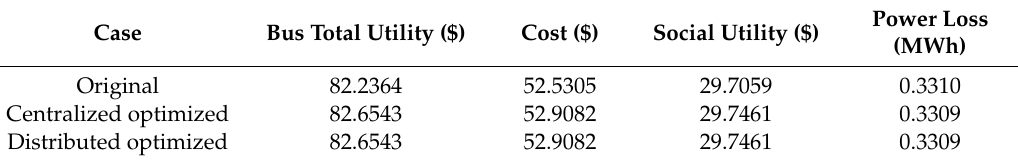
Table 6. Comparison of original and optimized case in 1 h.